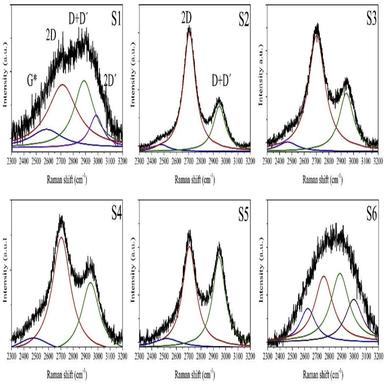
Deconvoluted Raman spectra for S1eS6 from 2300 cm1 to 3200 cm1 using Lorentz curves. Four vibration modes were identified G\-band at ~2500 cm1 , 2D-band at ~2700 cm1 , D þ D0 band at ~2950 cm1 and 2D0 -band at ~3050 cm1 . (A colour version of this figure can be viewed online.)